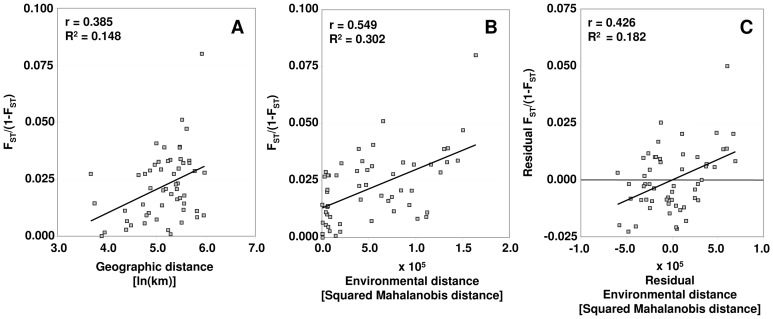
Isolation-by-distance and Isolation by environmental distance.Plots of simple and partial Mantel tests showing the relationships between A) geographic and genetic distances, B) environmental and genetic distances, and C) residual environmental and genetic distances, by taking into account the geographic distances among 11 populations of Fraxinus angustifolia.